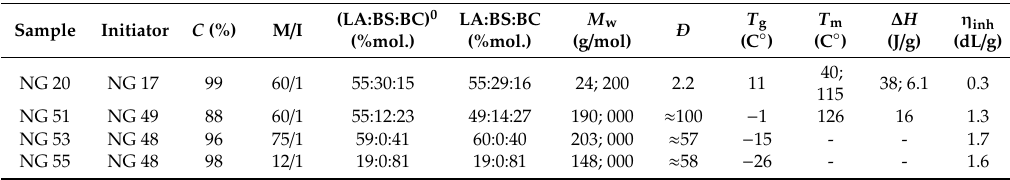
Table 3. Properties of the obtained poly( L -lactide)– block –poly(butylene succinate– co –butylene citrate) and poly( L -lactide)– block –poly(butylene citrate) copolymers.